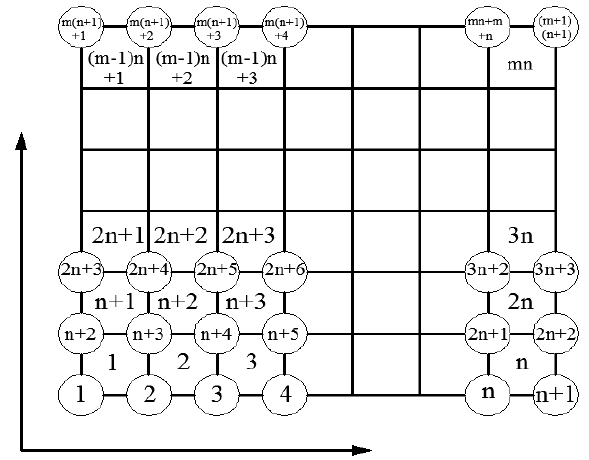
Figure 8. Sketch map of elements and nodes label for the CT image pixel matrix.